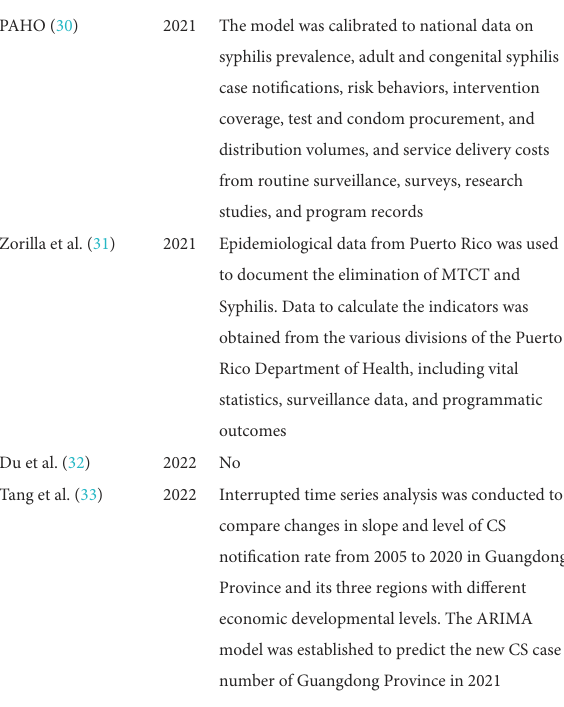
TABLE 3 Distribution of studies regarding monitoring and evaluating syphilis